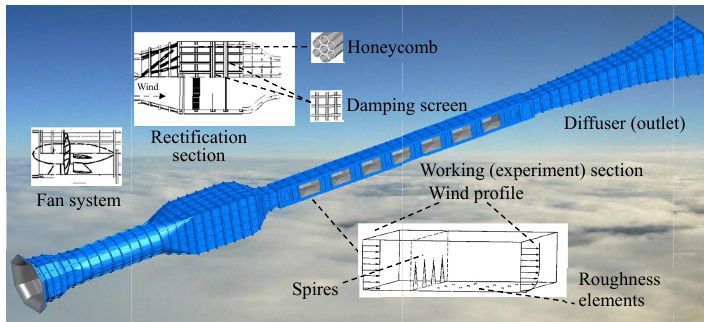
Figure 3. A sketch of the Lanzhou University wind tunnel.